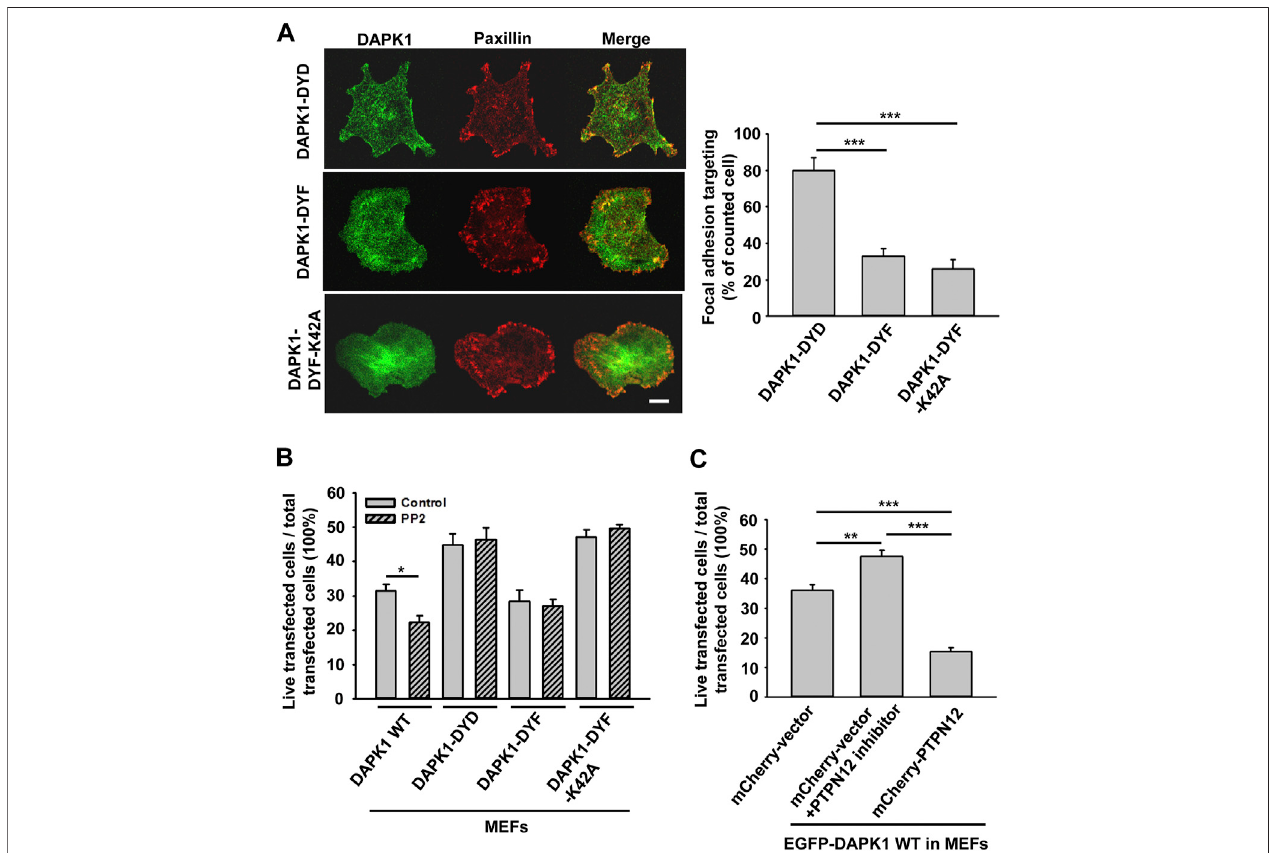
FIGURE 7 | DAPK1 apoptotic activity is controlled by Src phosphorylation and PTPN12. (A) Left: Micrographs showing the distribution of DAPK1 in MEFs transfected with mCherry-paxillin and EGFP-DAPK1-DYD (phosphomimetic mutant), EGFP-DAPK1-DYF (non-phosphorylated mutant) or EGFP-DAPK1-DYF-K42A (non-phosphorylated inactive mutant) respectively after 30 min spreading on fi bronectin-coated glass dishes. Scale bar: 10 μ m. Right: Percentage of FA targeting positive cells were calculated from 200 transfected cells per group. *** p < 0.001. (B) MEFs were transfected with EGFP-DAPK1 WT, EGFP-DAPK1-DYD, EGFP- DAPK1-DYF or EGFP-DAPK1-DYF-K42A respectively for 1 day. The percentage of transfected cells that were still alive was quanti fi ed. The mean ± SEM of at least two independent experiments is described. For each experiment, 100 – 150 cells were analyzed for each transfection point. * p < 0.05, *** p < 0.001. (C) MEFs were transfected with EGFP-DAPK1 WT either co-transfected with mCherry-PTPN12 or treated with PTPN12 inhibitor. The percentage of co-transfected cells that were still alive was quanti fi ed. The mean ± SEM of at least two independent experiments is described. For each experiment, 100 – 150 cells were analyzed for each transfection point. ** p < 0.01, *** p <